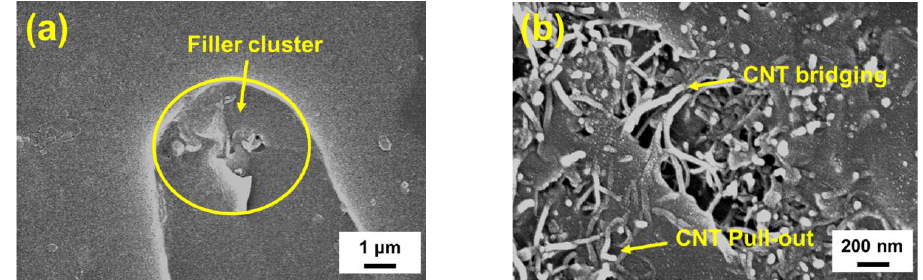
Figure 18. ( a ) Enlarged SEM images of crack bifurcation of the nanocomposites with a MWCNT:GNP ratio of 1:9. ( b ) SEM images of CNT bridging and pull-out of the nanocomposites with a MWCNT:GNP ratio of